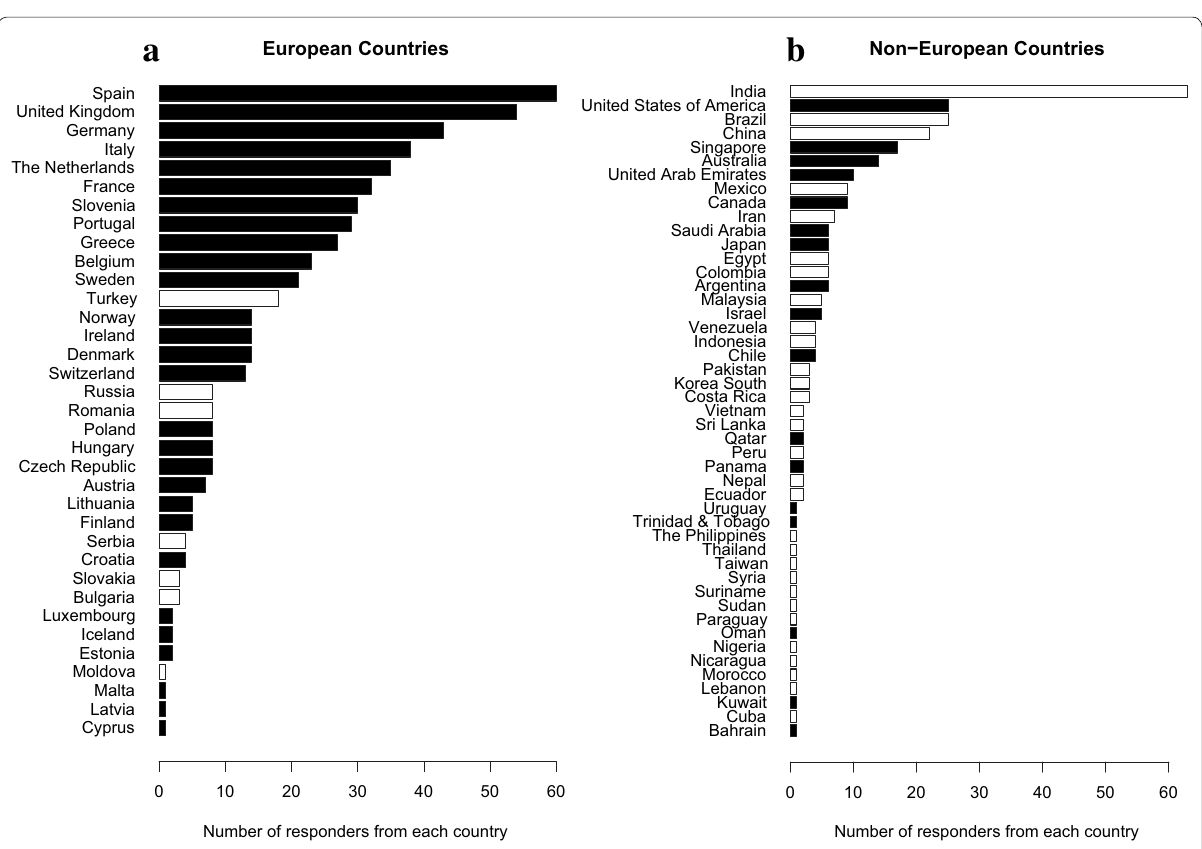
Fig. 2 a Survey respondents from European countries. Number of survey respondents working in European countries. Black bars indicate high‑income countries, and white bars lower‑income countries. b Survey respondents from Non‑European countries. Number of survey respondents working in Non‑European countries. Black bars indicate high‑income countries, and white bars lower‑income